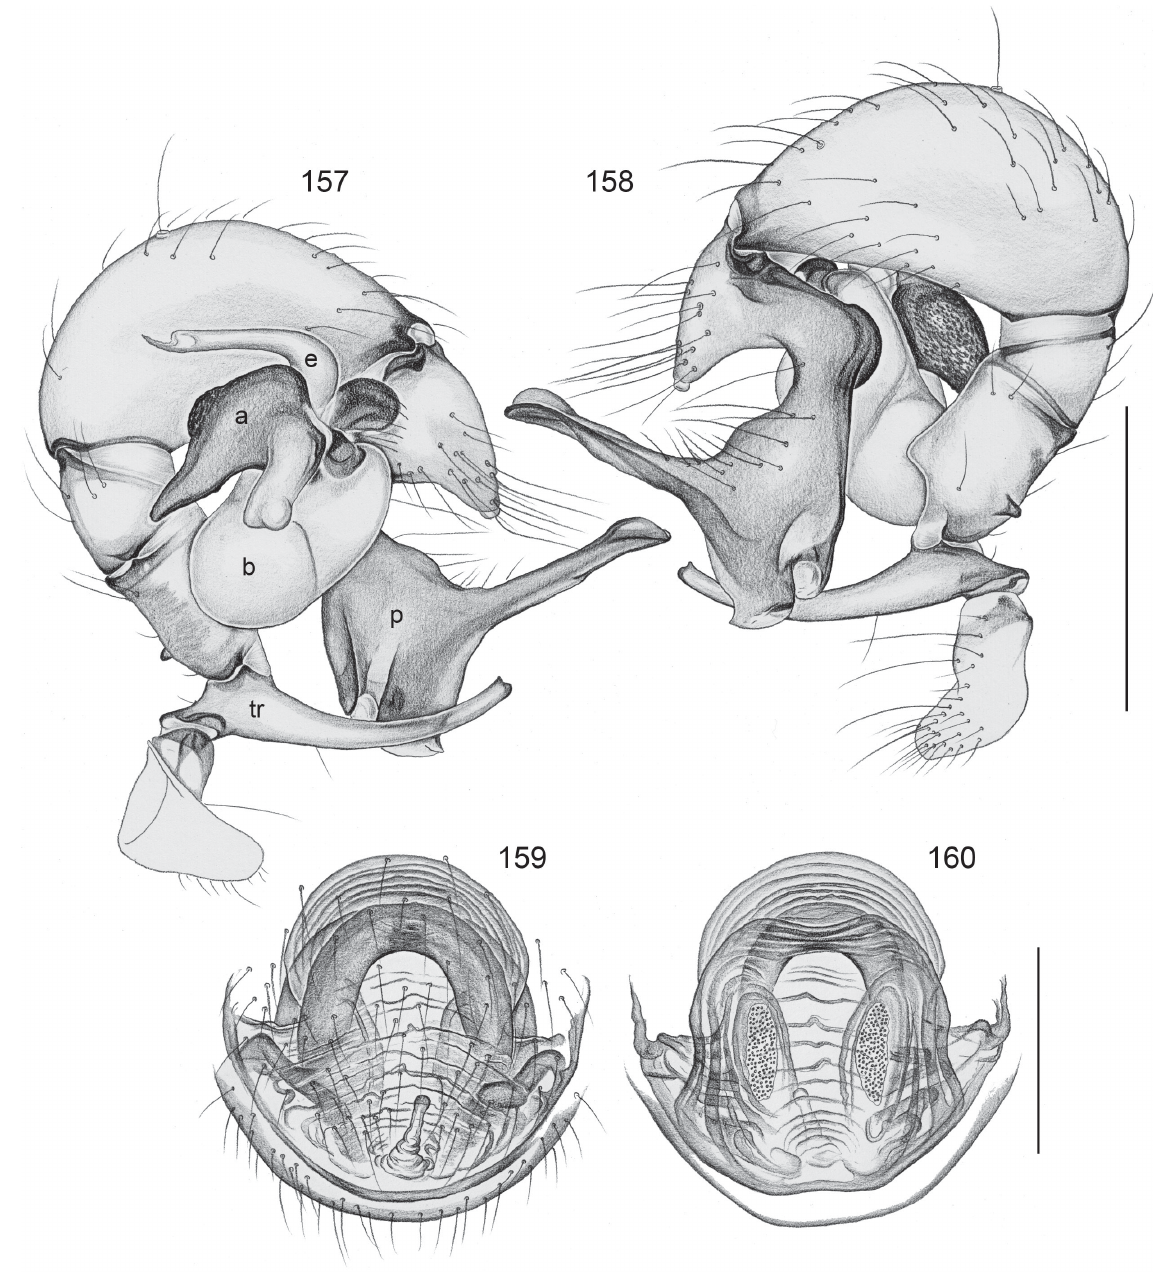
Figs 157–160. Pholcus matutum Huber sp. nov. (ZFMK, Ar 15730–31). 157–158 . Left male palp, prolateral and retrolateral views. 159–160 . Cleared female genitalia, ventral and dorsal views. Scale bars: 157–158 = 0.5 mm; 159–160 =